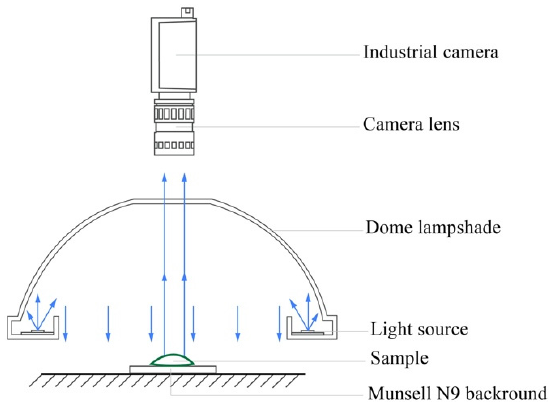
Figure 1. Schematic diagram of a computer vision system (CVS) device.